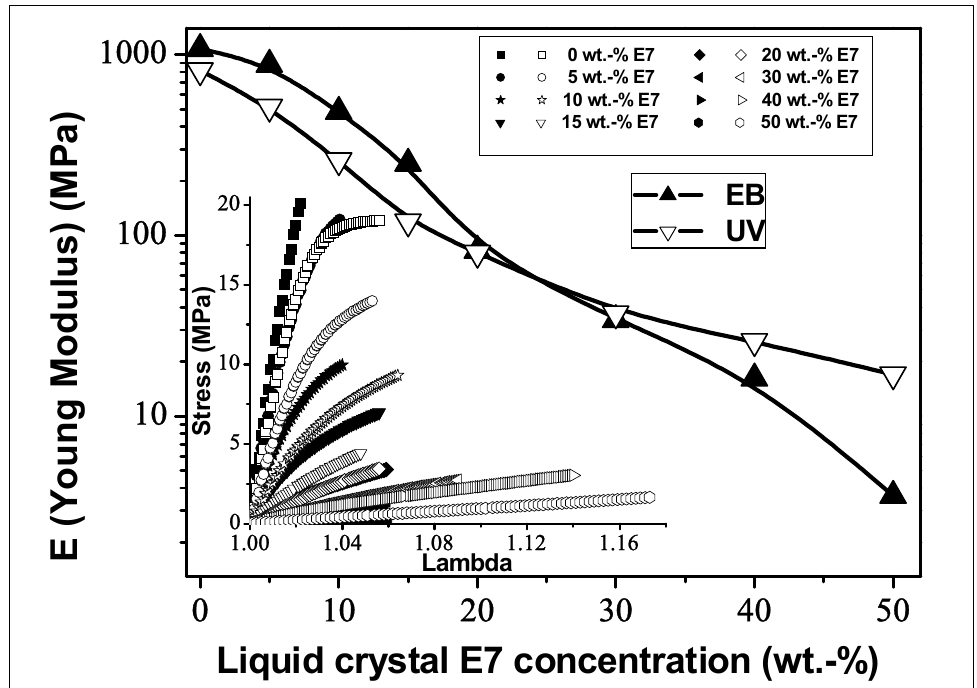
Figure 1. Static mechanical analysis: Dependence of Young modulus on LC concentration for both EB- and UV-cured TPGDA/E7 systems. The insert shows stress as a function of draw ratio λ for the same samples.